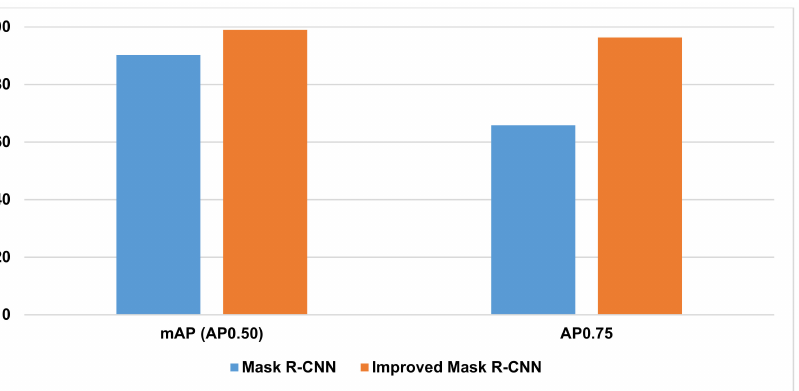
Figure 12. Results of mAP when AP = 0.50 and AP 0.75 for the training dataset for default and improved Mask R-CNN.